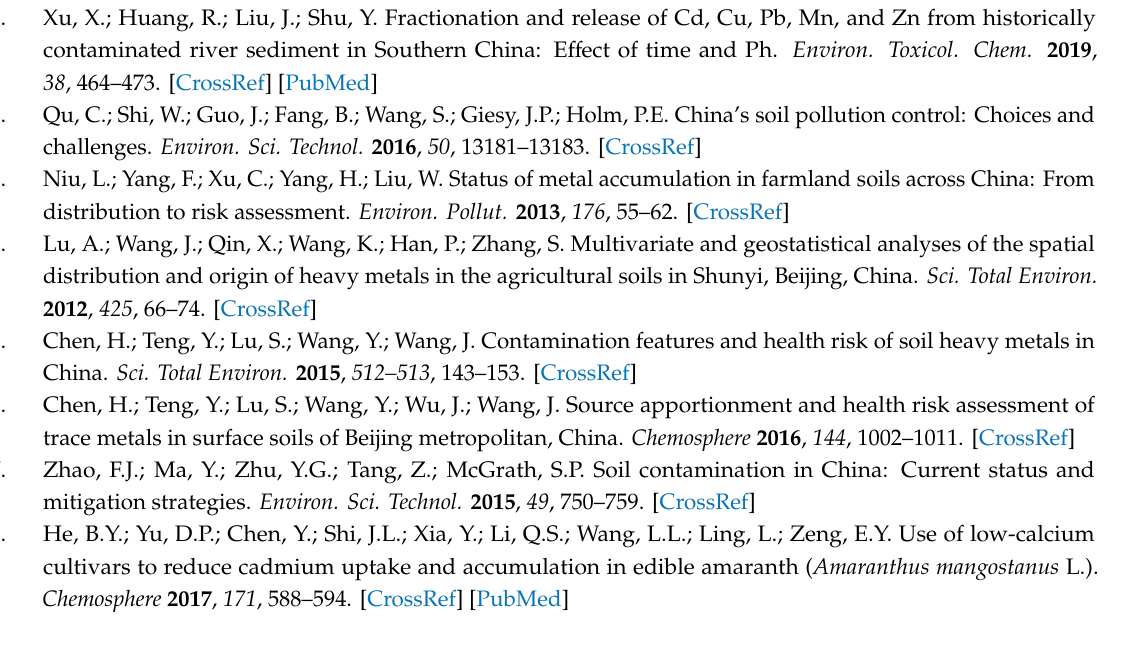
Table S1: The properties of the soil and BC, Table S2: Elemental compositions and atomic ratios of biochars, Table S3: Extractants used in sequential extraction of metal in soil, Table S4 Comparison of sorption capacity of Cu with biochars derived from di ff erent materials, Table S5: E ff ects of the application of BC on an increase / decrease in silicon content / DOC content in